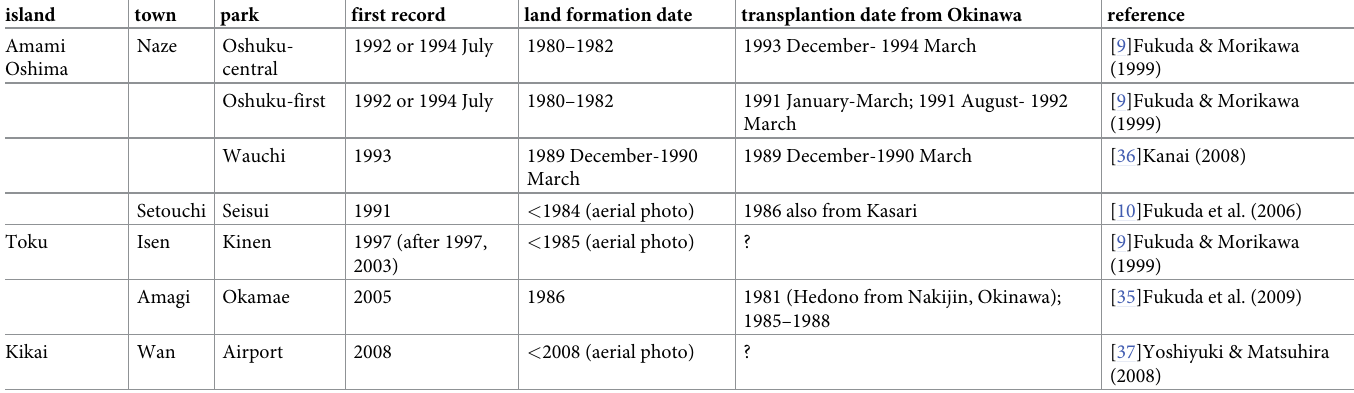
Table 2. Summary of dates of first records of Cryptotympana facialis and transplantation dates for the Amami islands after references shown on this table. For land formation (human landscaping) dates, documentation by archival aerial photos offered by Geospatial Information Authority of Japan are referenced.